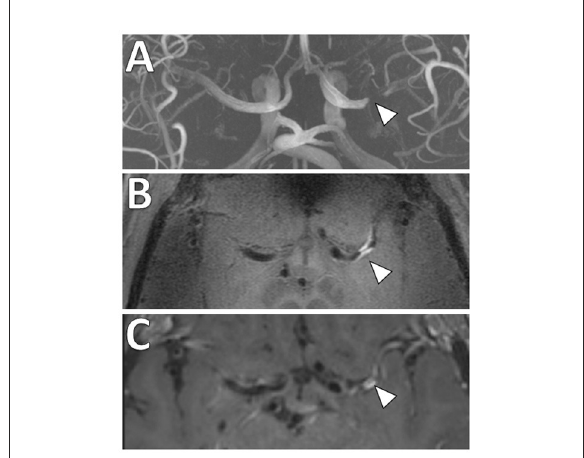
FIGURE7 Comparison of 3 and 7 Tesla (T) VW-MRI for intracranial atherosclerosis. A patient with history of obesity, hyperlipidemia and hypertension and ischemic stroke underwent a (A) 7T TOF-MRA, which showed left M1 middle cerebral artery severe stenosis (arrowhead). (B) 7T MRI axial T1 SPACE post-gadolinium (0.5mm isotropic resolution) image clearly delineates arterial wall thickening and avid vessel wall enhancement in the region of stenosis (arrowhead). (C) The same patient was imaged 18 days later on a 3T MRI (T1 SPACE post-gadolinium, 0.8 × 0.8 × 1.0mm) to assess the stenosis (arrowhead). The 7T VW-MRI shows improved conspicuity and delineation of the margins of the arterial wall compared to the 3T, an advantage of the higher magnet strength due to the higher signal to noise leveraged for higher spatial resolution and soft tissue